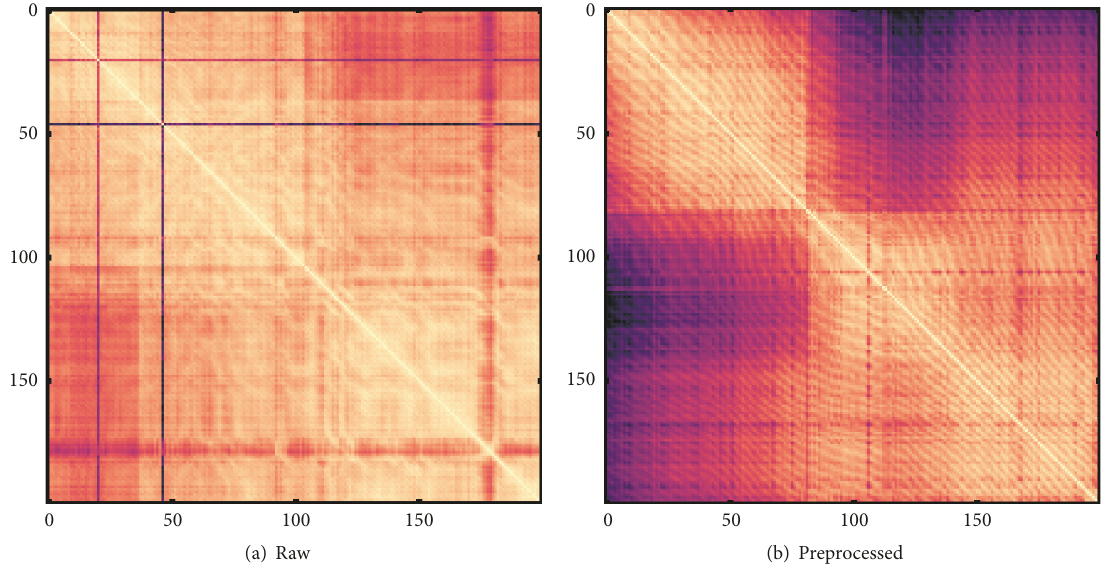
Figure 2: Raw and preprocessed fMRI